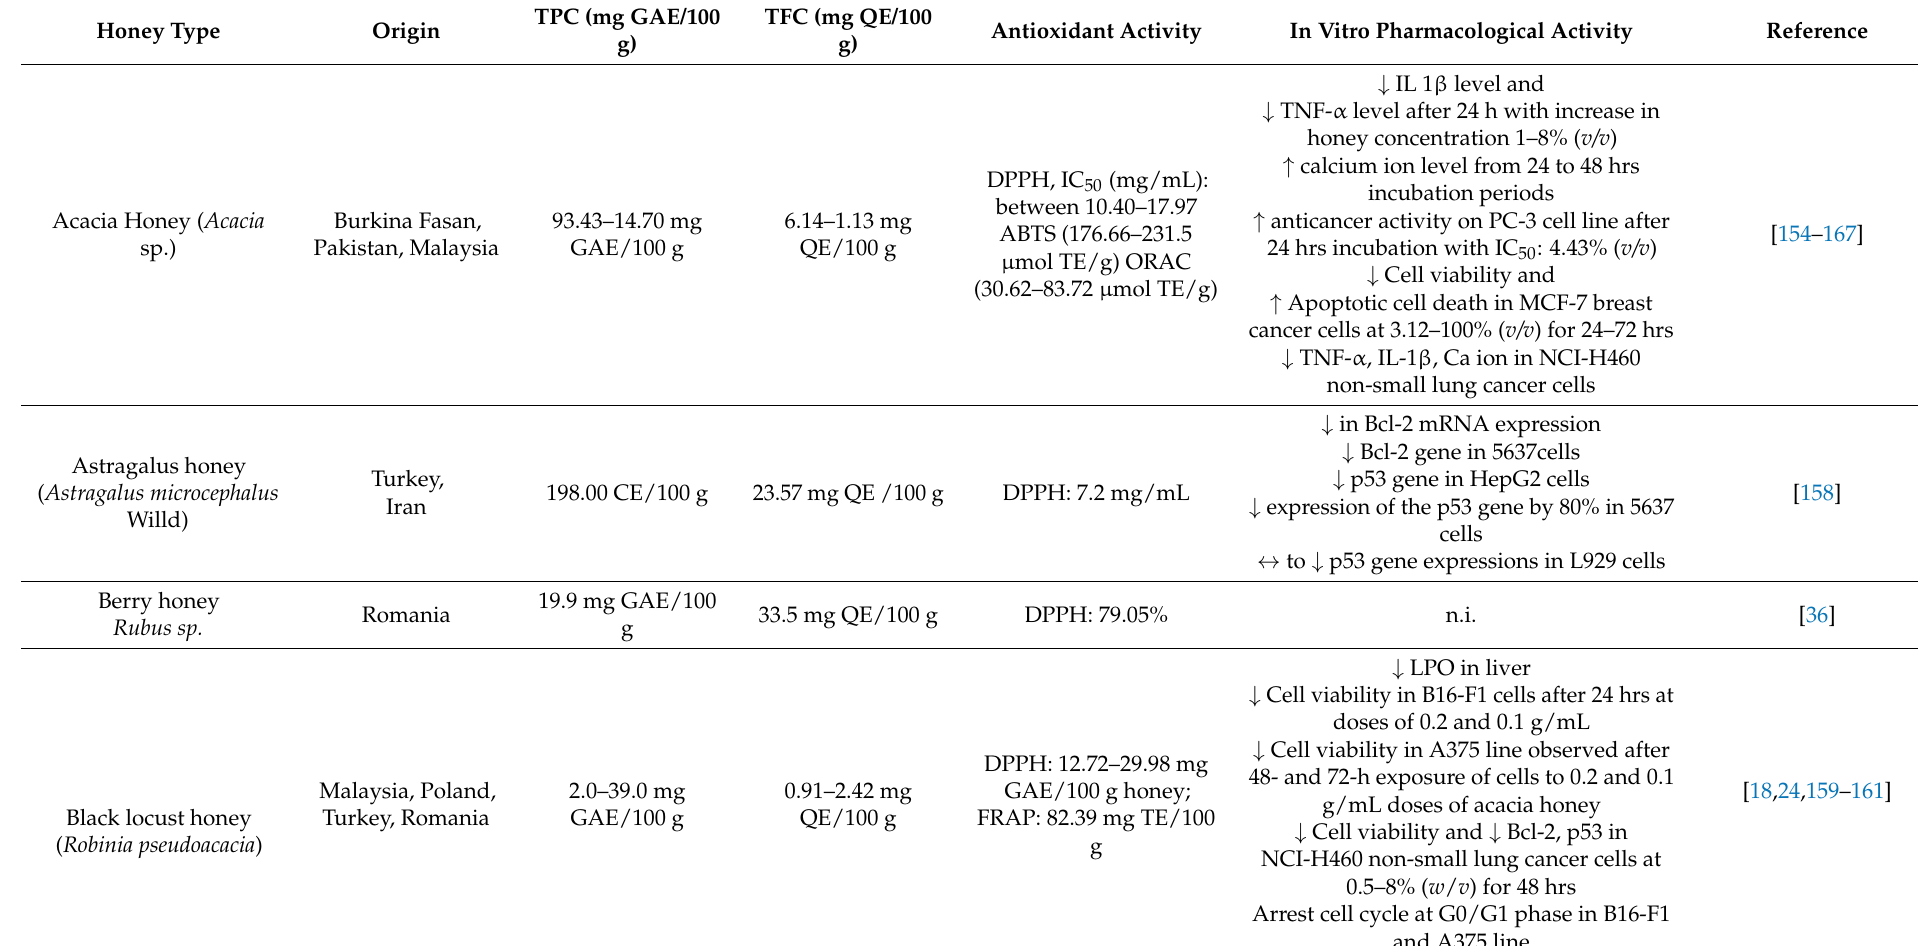
Table 5. Phenolic compounds, antioxidant capacity, and in vitro pharmacological studies of monofloral